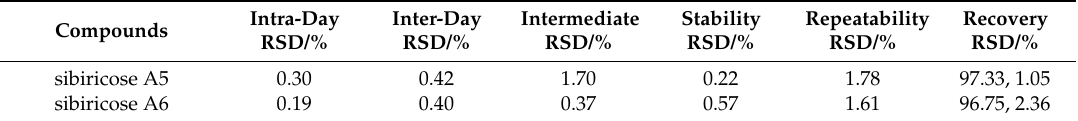
Table 2. Intra-day and inter-day precisions, stability, repeatability, and recovery for the nine components ( n = 6). RSD: relative standard